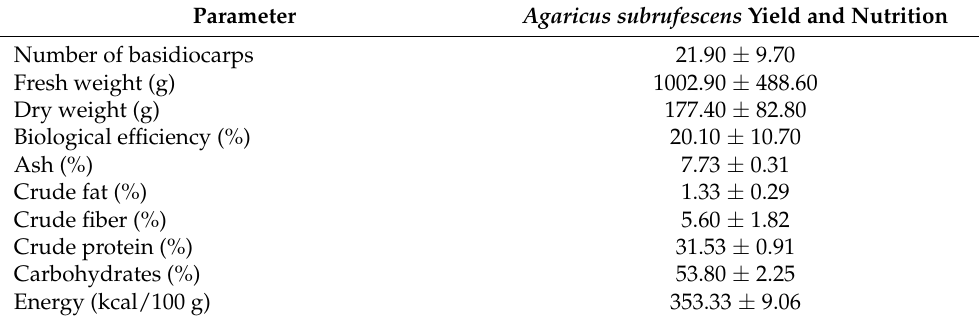
Table 3. Basidiocarps yield, biological efficiency, proximate composition, and energy of Agaricus subrufescens